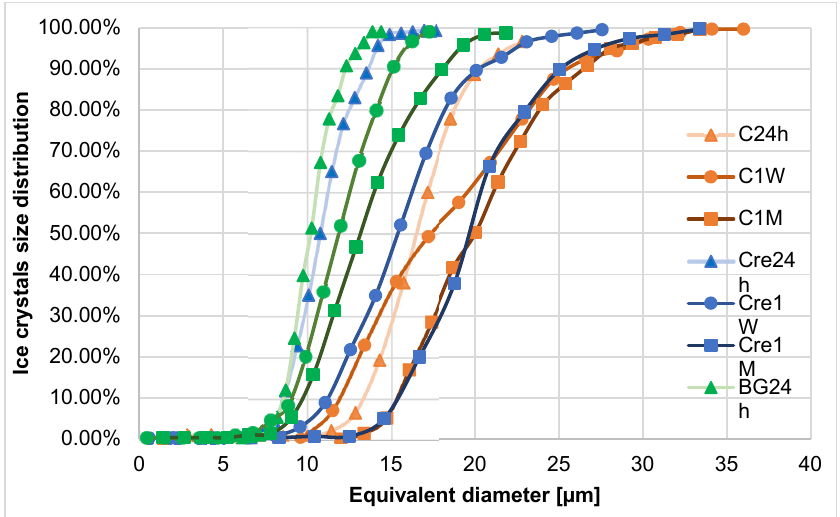
Figure 5. Ice crystal size distribution in milky ice cream with and without stabilizers after different storage time (24 h, 1 week (1 W), and 1 month (1 M)): C is low ‐ fat milky ice cream without stabilizer (control); Cre is low ‐ fat milky ice cream with 0.5% of Cremodan ® SI 320; BG is low ‐ fat milky ice cream with 0.5% of oat β‐ glucan. After one week of storage in a non ‐ stabilized sample, 50% of examined crystals di ‐ ameters (X50) were at the level of 20 μ m and, after 1 month of storage, it was noticed at the level of 22.32 μ m (Figure 5). It was already showed that even after one month of stor ‐ age, in milky ice cream without stabilizers, ice crystals could rise bigger than 50 μ m [8,11,37,38]. For a sample with Cremodan ® SI 320, it is obvious that the addition positively influences ice crystals diameters just after production and in a short period of storage. For two investigated variants with additives, the smallest ice crystals were created in milky ice cream with a β‐ glucan addition (Figure 5 and Table 2) and an X50 parameter; even after 1 month of storage, it was at the level of 12.96 μ m, while for the sample with Cremo ‐ dan ® SI 320, it was already 17.69 μ m (Figure 6).